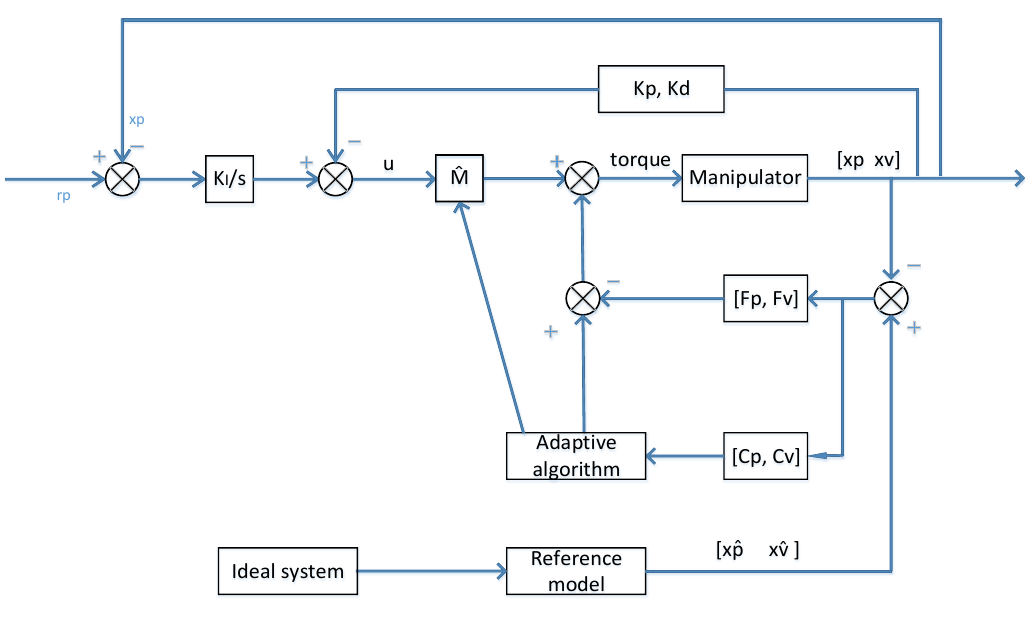
Figure 4. Model reference control approach.